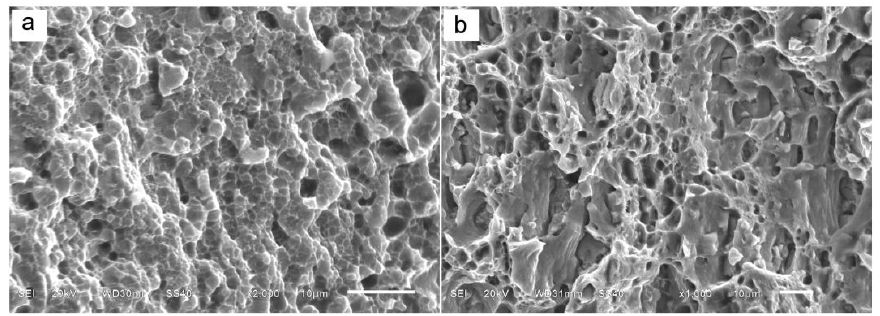
Figure 11. Scanning electron microscopy (SEM) images showing the tensile fracture surface of ( a ) FSLW samples and ( b ) rolled